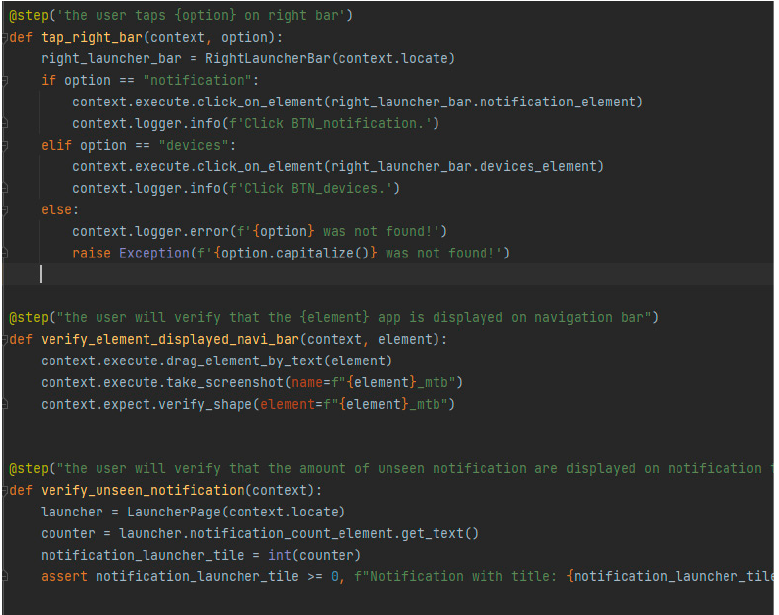
Figure 19. Example of correct steps definition with LEE.